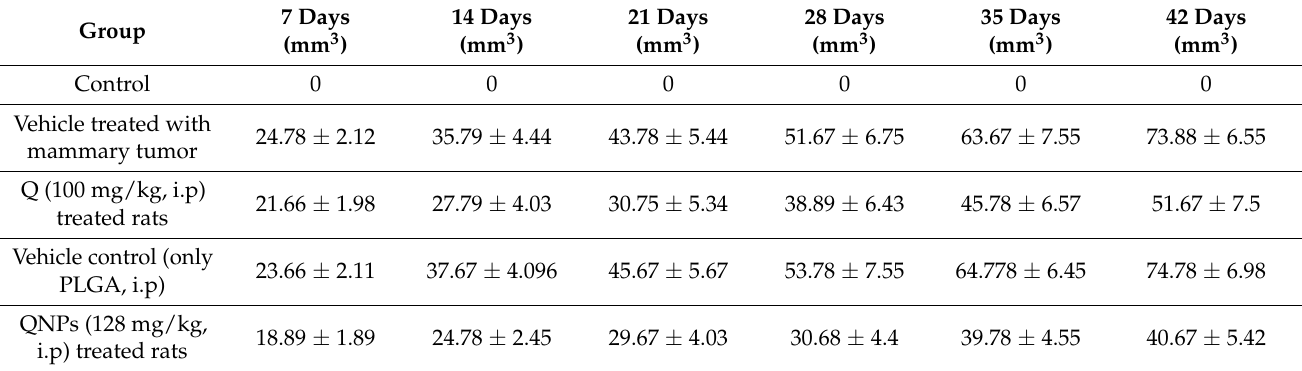
Table 1. Anticancer effect of QNP post-treatment on tumor volume (mm 3 ) in breast cancer rats. All the values are expressed as mean ± SEM ( n = 6).